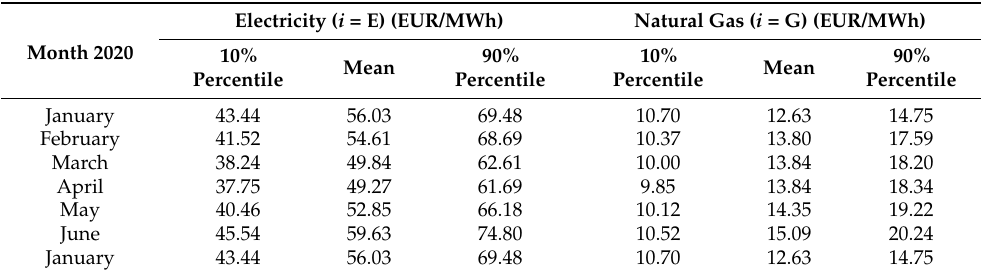
Table 4. Mean and percentiles of monthly simulated electricity and natural gas prices.